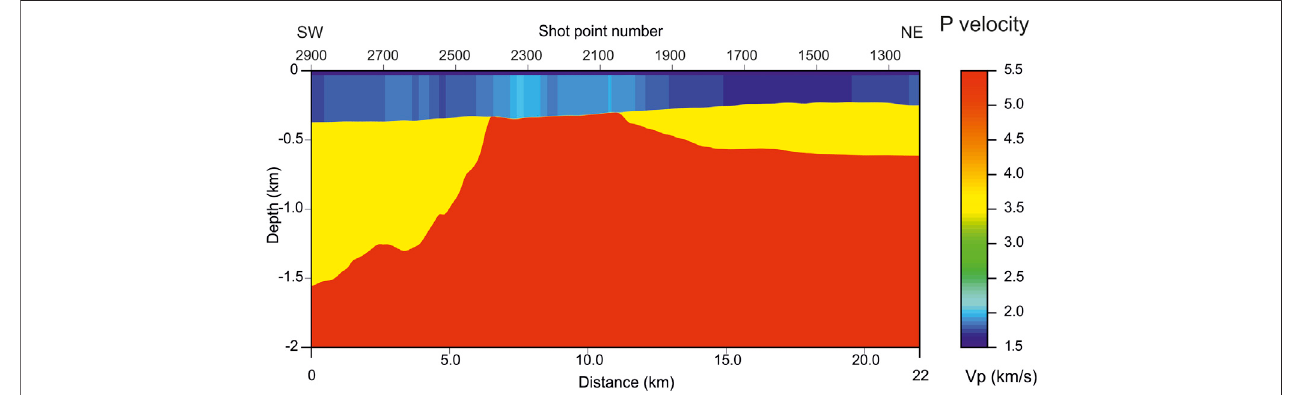
FIGURE 7 | Tomographic estimation of the P velocity by the traveltime inversion of re fl ected arrivals from a few shallow horizons of the pro fi le GT09 – 21.